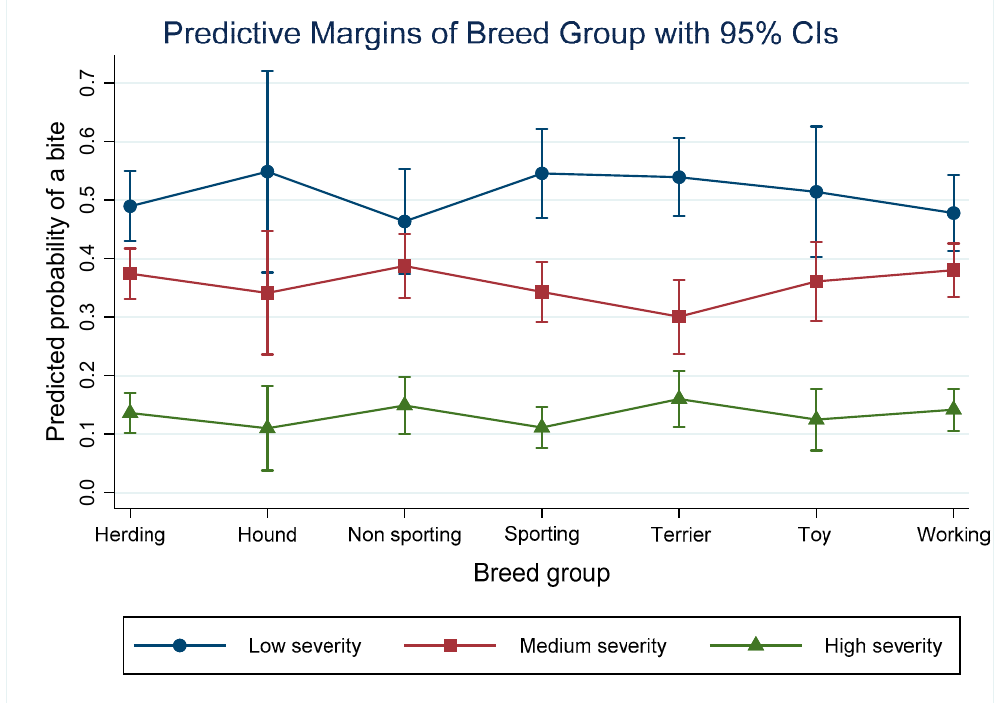
Figure 1. Predictive margins for the different severity incidents depending on the breed grouping and controlling for other variables in the model.